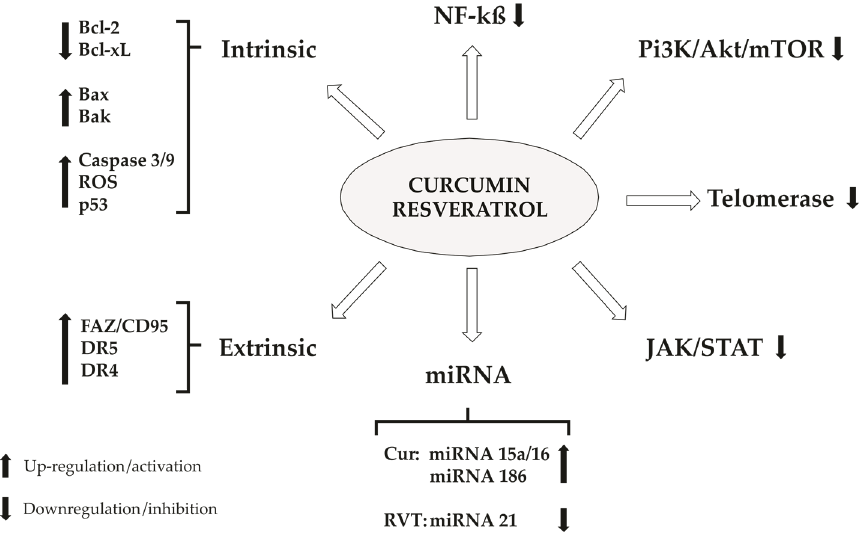
Figure 3. General scheme about curcumin and resveratrol effects in apoptosis.